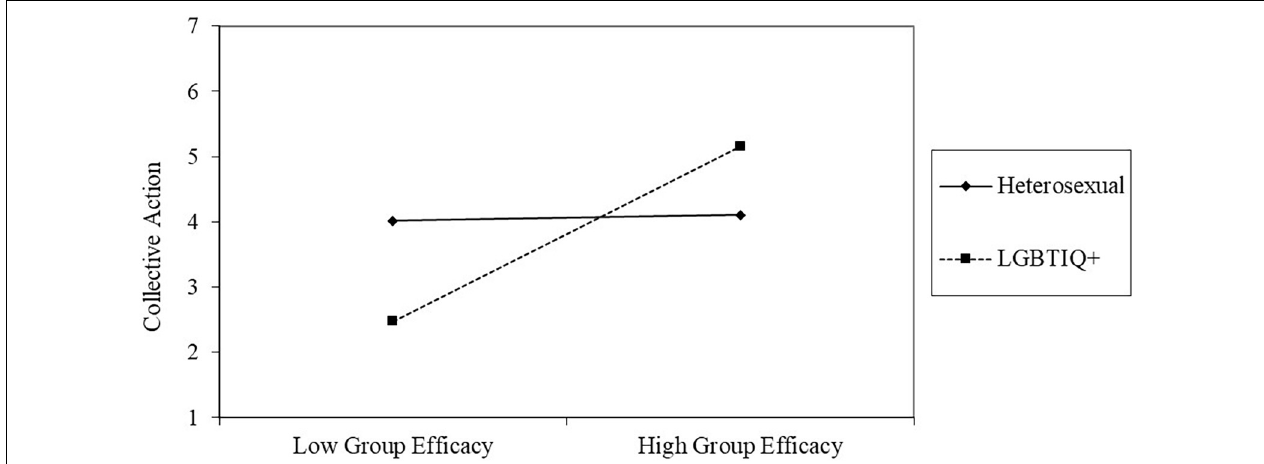
FIGURE 1 | Group efficacy beliefs moderated by group membership on future collective action